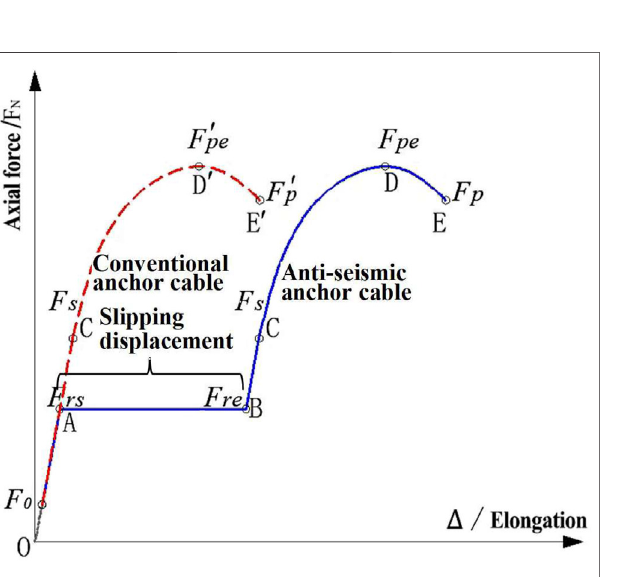
Frontiers in Earth Science |